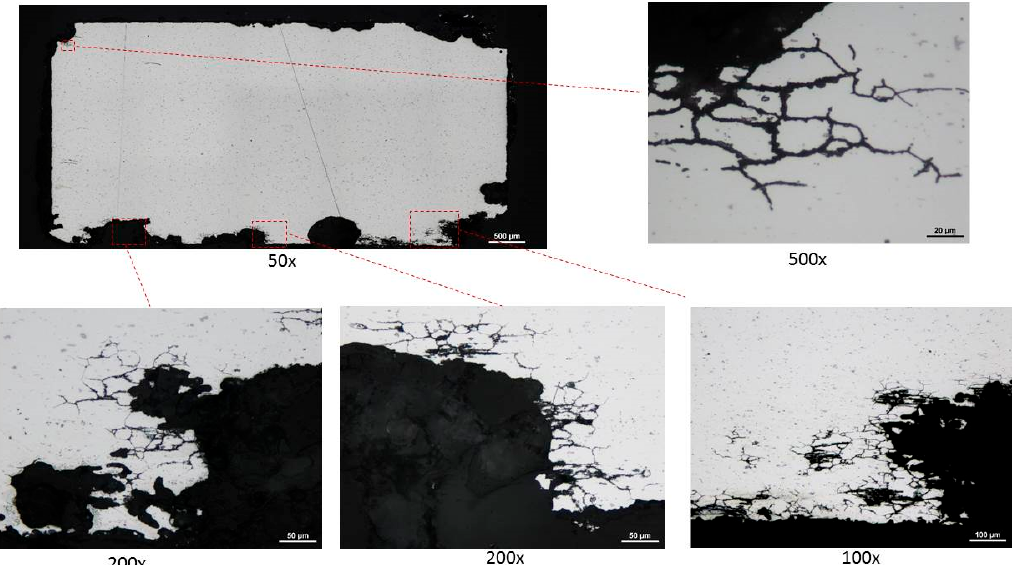
Figure 12. Metallographic section of wrought Al 6061-T6 stressed at 25% of yield strength after 90 days exposure to B117 salt fog testing. Various locations show pitting and intergranular crack branching.